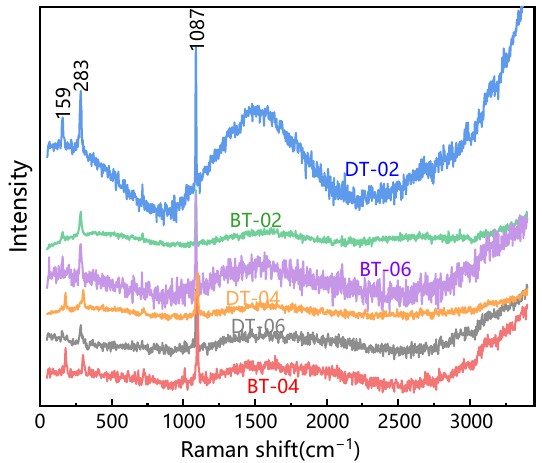
Figure 11. Raman spectra obtained for ground layer materials.